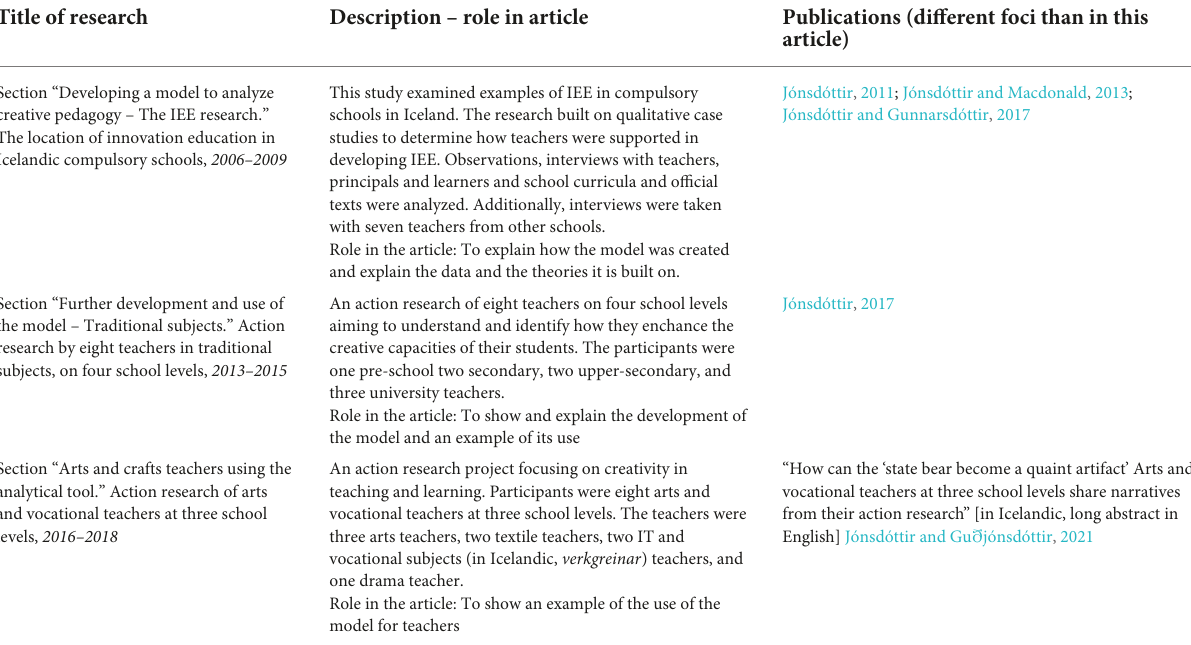
TABLE 1 The three research projects presented in the